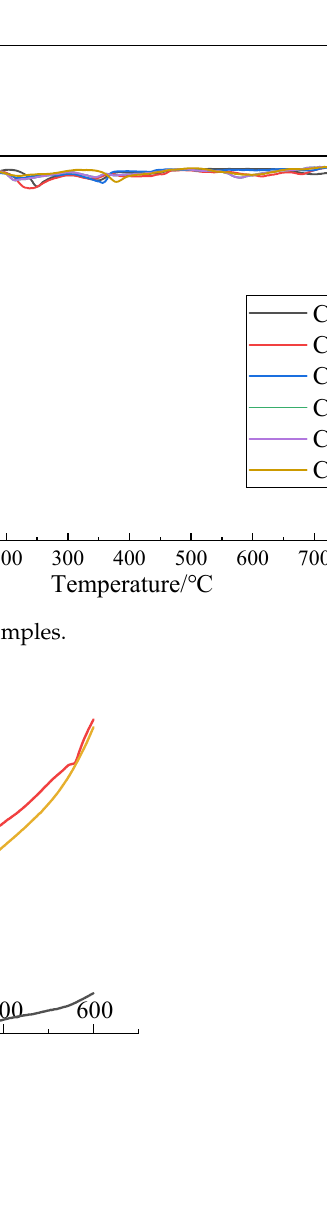
Figure 9. DSC curves of the Samples.